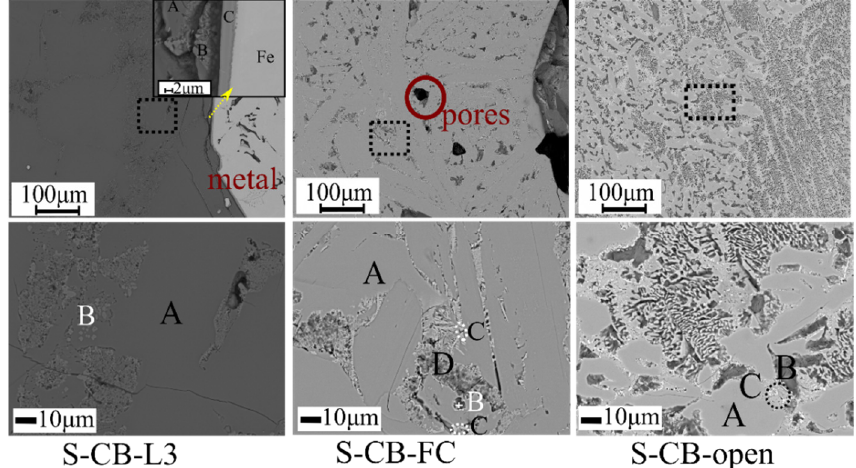
Figure 11. SEM backscattered electron images of S-CB-L3, S-CB-FC, and S-CB-open slags. The major phase in the S-CB-L3 is a homogeneous dark grey phase (Phase A-L3) that is mainly composed of Ca and Al. The Ca/Al ratio is approximately 0.96. Thereafter, the phase A-L3 might be attributed in the C 5 A 3 phase detected in the XRD analysis. A brighter in appearance phase is also formed (phase B-L3) to a lesser extent and is mainly concen- trated around the main phase A-L3 in a random distribution. Table 4. Averaged chemical composition of slag phases for the samples S-CB-L3, S-CB-FC and S- CB-open based on EDS point analysis and metal phases based on EPMA (WDS) analysis.